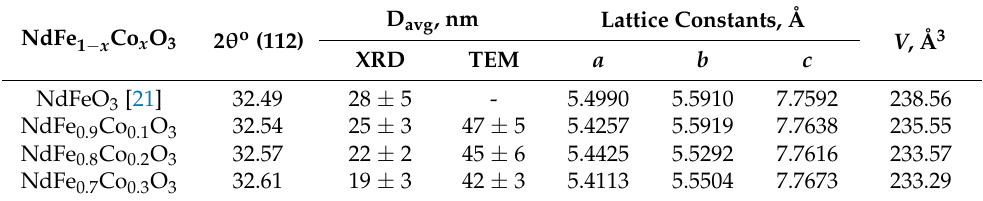
Figure 2. Slow-scan XRD patterns of peak (112) of NdFe 1- x Co x O 3 samples annealed at 750 °C for 60 min. Table 1. Lattice parameters and crystallite sizes of NdFe 1 − x Co x O 3 samples annealed at 750 ◦ C for 60